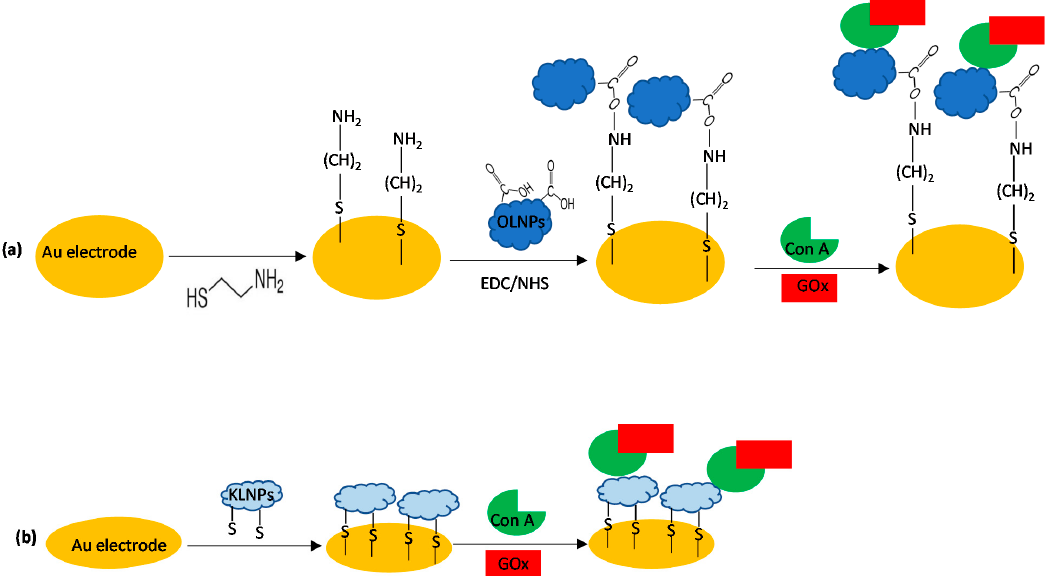
Scheme 2. Preparation of gold modified electrodes: ( a ) Au/SAMCys/organosolv nanoparticles (OLNPs)/ConA/GOx and ( b ) Au/kraft lignin nanoparticles (KLNPs)/ConA/GOx. The KLNPs biosensor (Au/KLNPs/GOx) was prepared by immersing the clean bare gold electrode in a solution of kraft lignin nanoparticles (KLNPs, 2 mg mL − 1 ) for 2 h in darkness at room temperature. Then, ConA and GOx enzyme were added as described above for the first biosensor (Scheme 2b). Layer-by-Layer Nanoassembly Two and three layers of the KNLPs/ConA/GOx biolayer were successively deposited onto the Au electrode according to a self-assembly LbL procedure (Scheme 3), as reported above for the first layer.